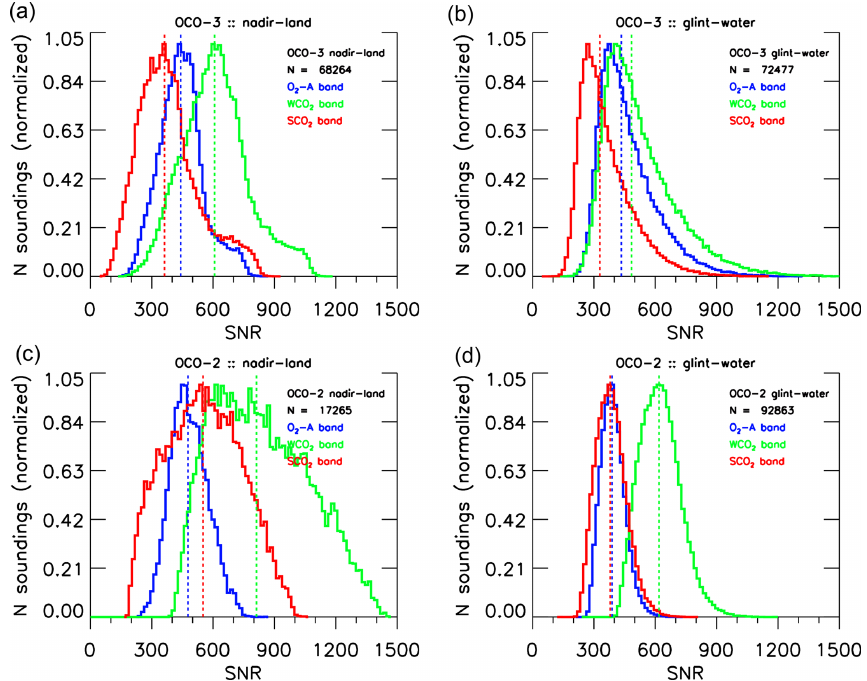
Figure 8. SNR histograms comparing simulated OCO-3 (a, b) to operational B8 OCO-2 (c, d) for nadir–land (a, c) and glint–water (b, d) . The colors represent the three spectral bands, as described in the legend. Both datasets have been filtered using their respective L2FP quality flags. The median value for each spectral band is shown as a vertical dashed line in the corresponding